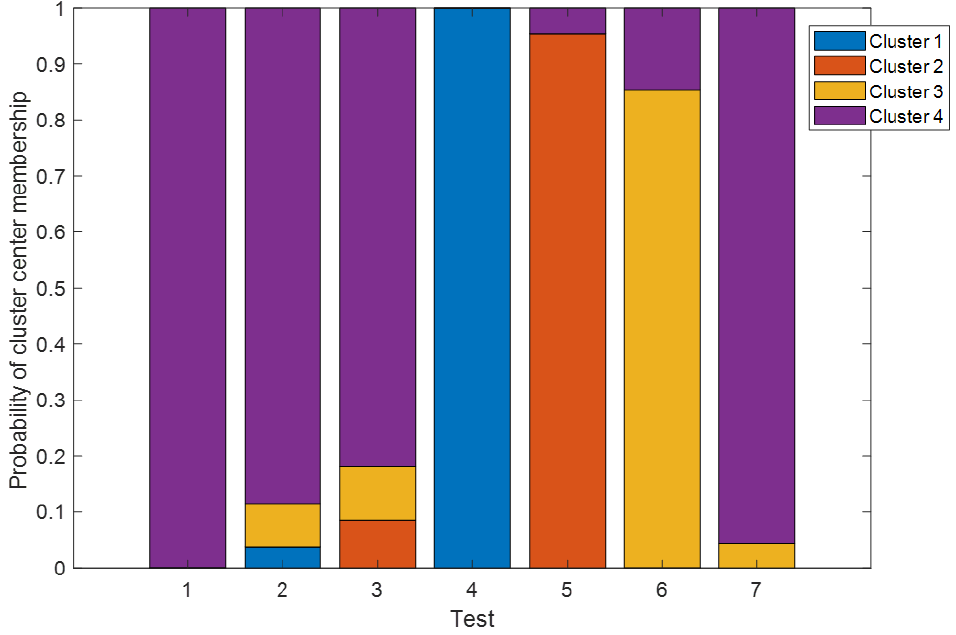
Figure 11. Probability or degree of cluster center membership to the individual quality observation of the respective test classes in 6 PCA dimensions.